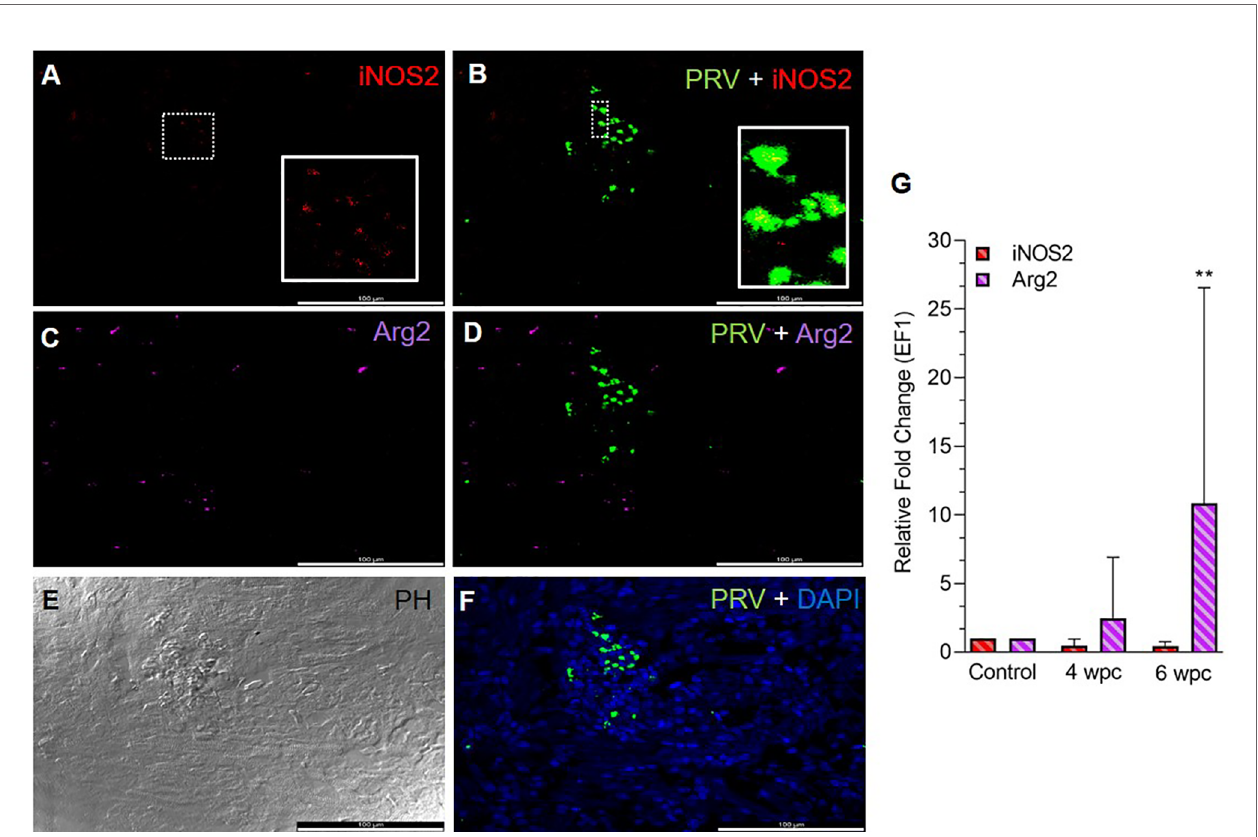
FIGURE 1 | Fluorescent in situ hybridization (FISH) of iNOS2, Arg2 and PRV-1 (A – F) in heart tissue at the peak of HSMI (6 wpc). (A) A limited number of iNOS2 (red) positive M1 macrophages were detected. (B) Merged image showing modest co-localization of PRV-1 and iNOS2 (inset). (C) Widely distributed Arg2 (purple) positive M2 macrophages. (D) Merged image does not show co-localization of PRV-1 and Arg2-positive M2 macrophages. (E) Phase contrast image showing aggregated blood cells in the stratum spongiosum layer. (F) PRV-1 (green) infected cells amongst clustered blood cells. Cellular nuclei stained with DAPI (blue) (Scale Bar = 100 µm). (G) Relative fold change expression (medians) of iNOS2 and Arg2 at 4 wpc and 6 wpc normalized against EF1 a expression. (*) shows signi fi cant difference from the control (**p <